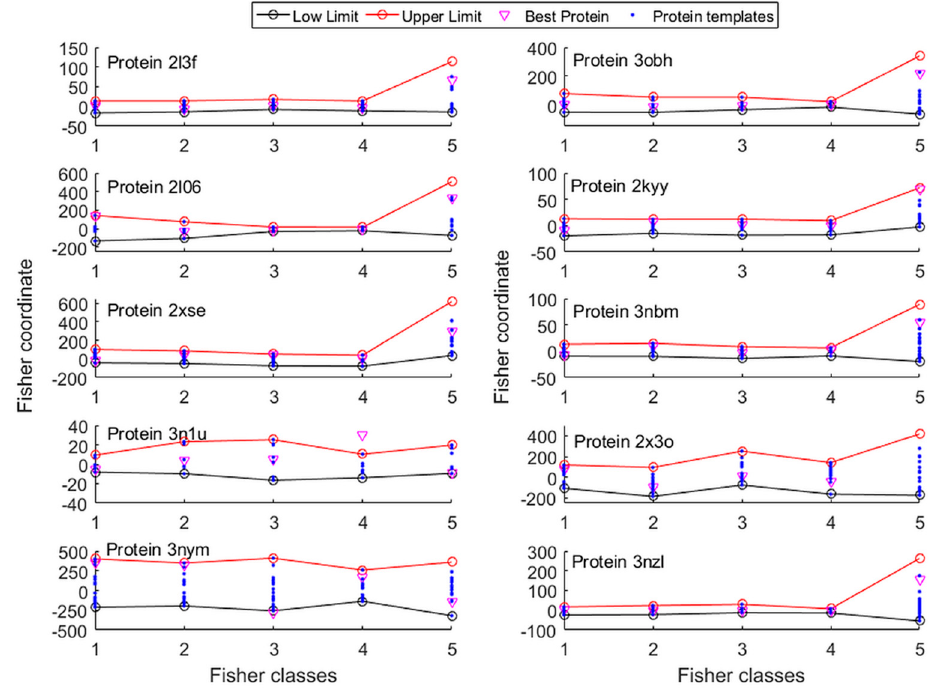
Figure 6. Protein search space constructed via L2-regularized LDA.